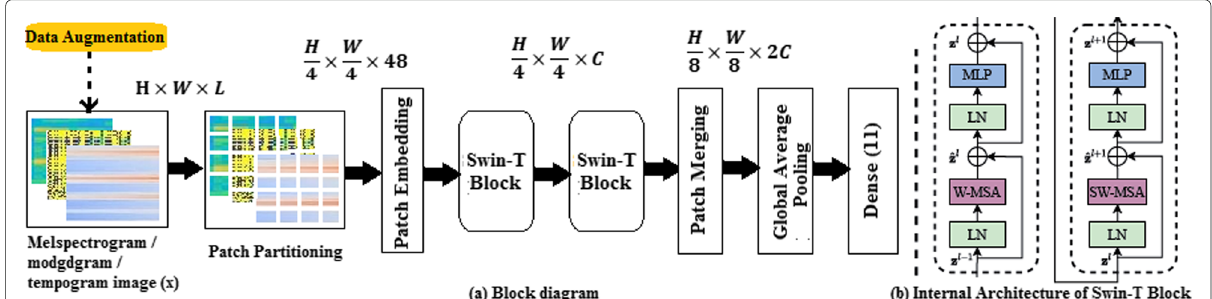
Fig. 3 (a) Block diagram of the proposed method of Swin transformer, (b) Internal architecture of Swin-T